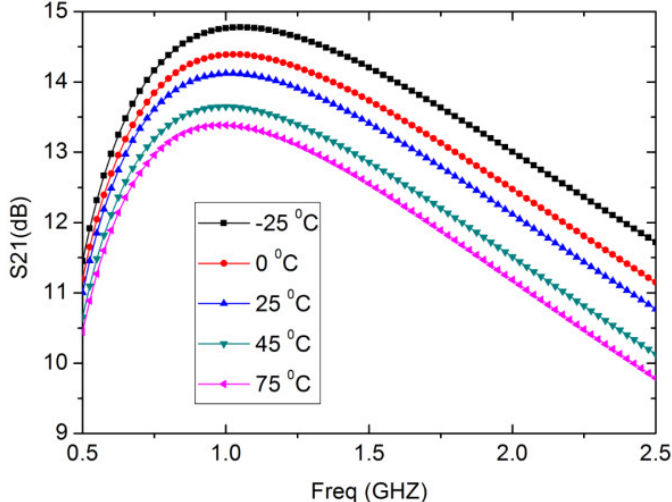
Figure 8. Simulated S21 of the wideband LNA with temperature variations.